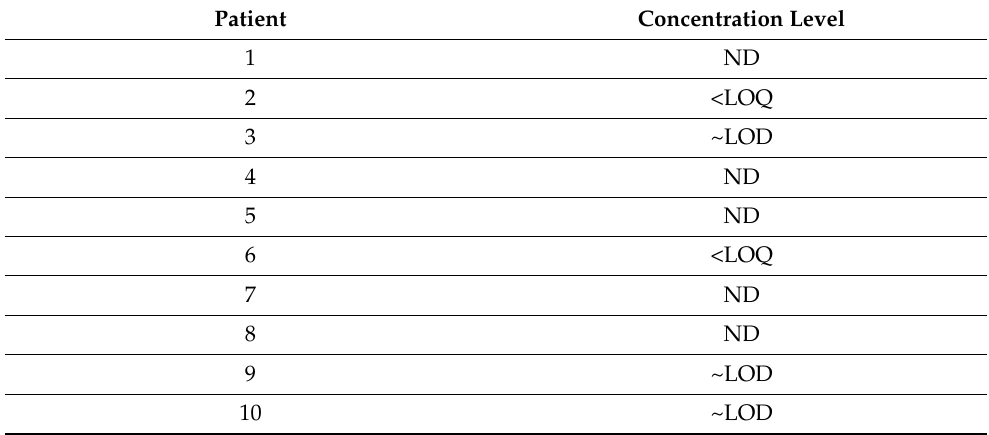
Table 3. Results of quantitative analysis for BPA in 10 human breast milk samples. ND—not